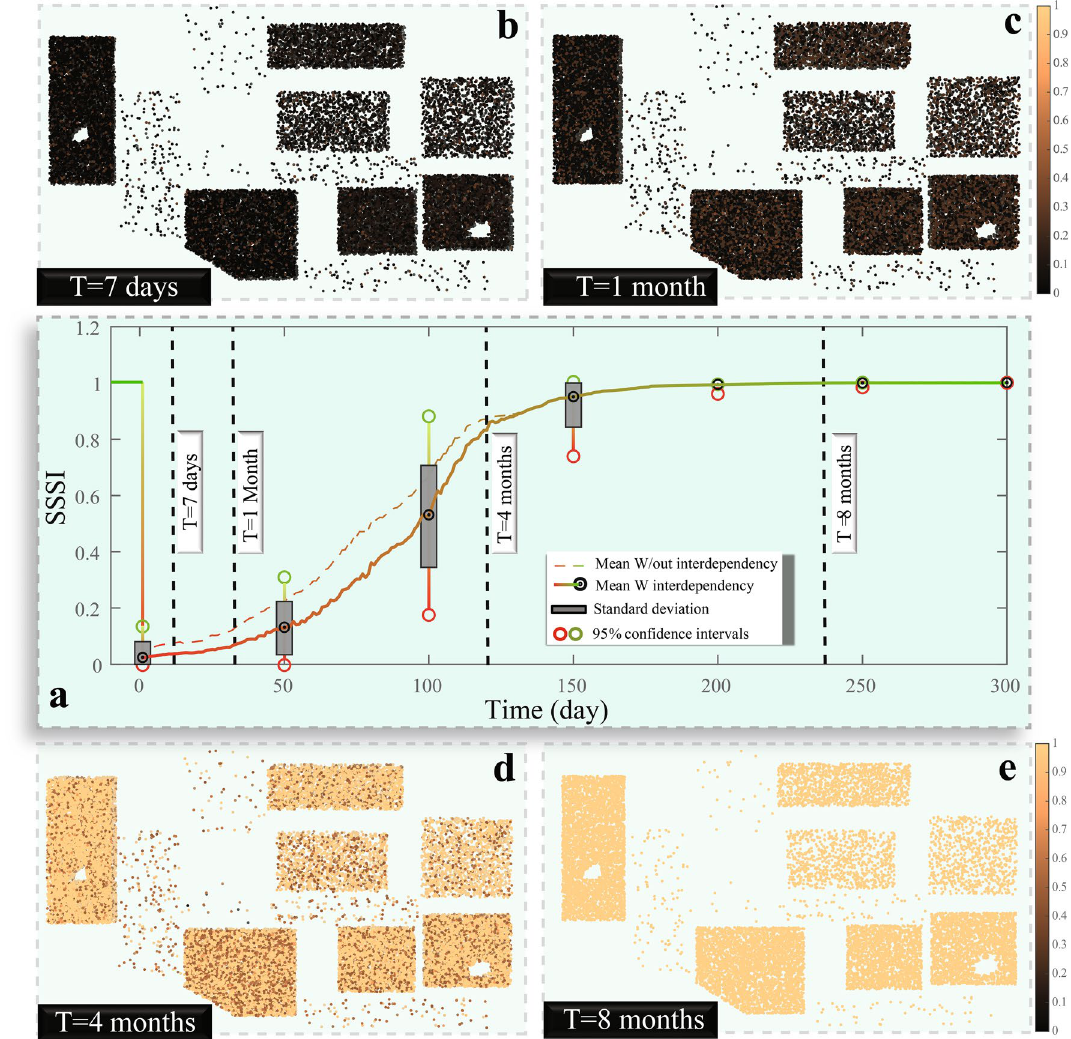
Figure 4. ( a ) Recovery of the SSSI over time, and the spatial distribution of the SSSI after ( b ) 1 week, ( c ) 1 month, ( d ) 4 months, and ( e ) eight